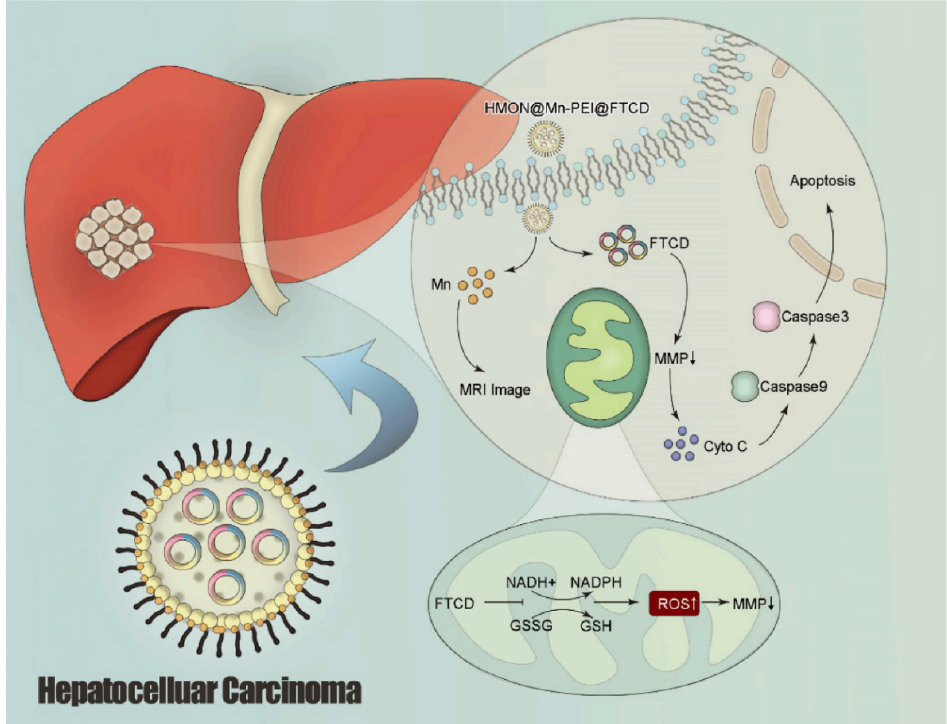
Figure 5. Schematic diagram of the mechanism of HMON-loaded FTCD nanoparticles in hepatocellular carcinoma, by activating mitochondrial apoptosis signaling pathway. Reprinted with permission from Ref. [71]. Copyright 2022 Elsevier Ltd.